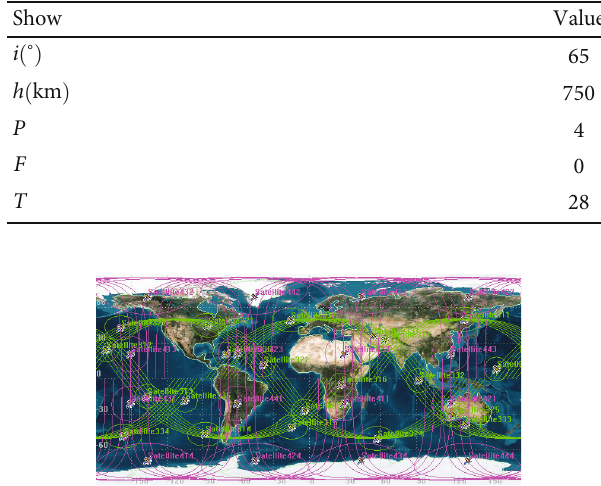
Table 2: Constellation 2.